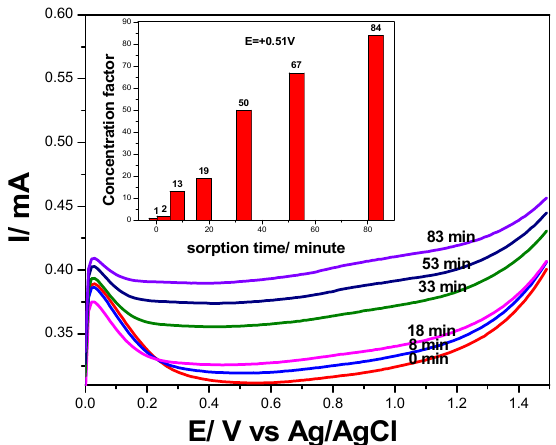
Figure 11. Differential pulse voltammograms recorded on GRQD/CNT paste electrode in the presence of 0.0004 mgL − 1 doxorubicin concentrations with different accumulation times; SP of 10 mV, MA of 200 mV; frequency of 10 Hz, and a scan rate of 100 mVs − 1 , potential range: 0.000 to +1.50 V /Ag/AgCl. Inset: Voltammetric signals achieved by DPV recorded in the presence of 0.0004 mgL − 1 DOX in 0.1 M Na 2 SO 4 supporting electrolyte at GRQD/CNT electrode, as a function of the sorption time in the preconcentration step prior to the detection recorded at E = +0.510 V vs. Ag/AgCl.